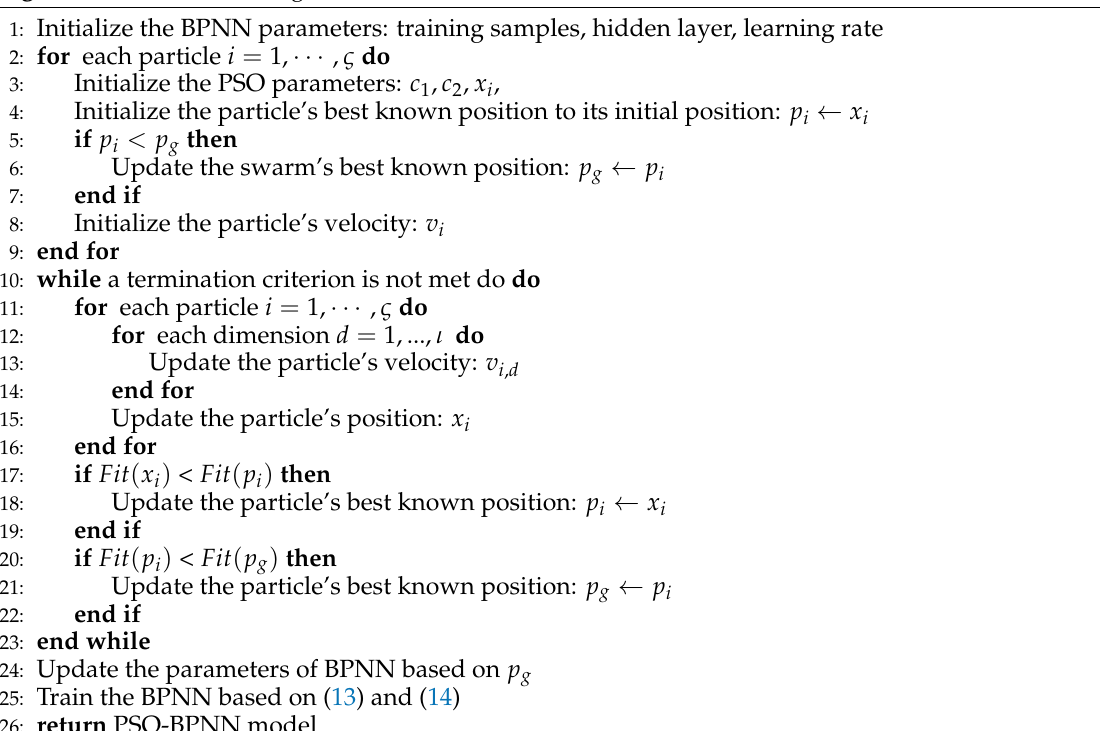
Algorithm 1 PSO-BPNN